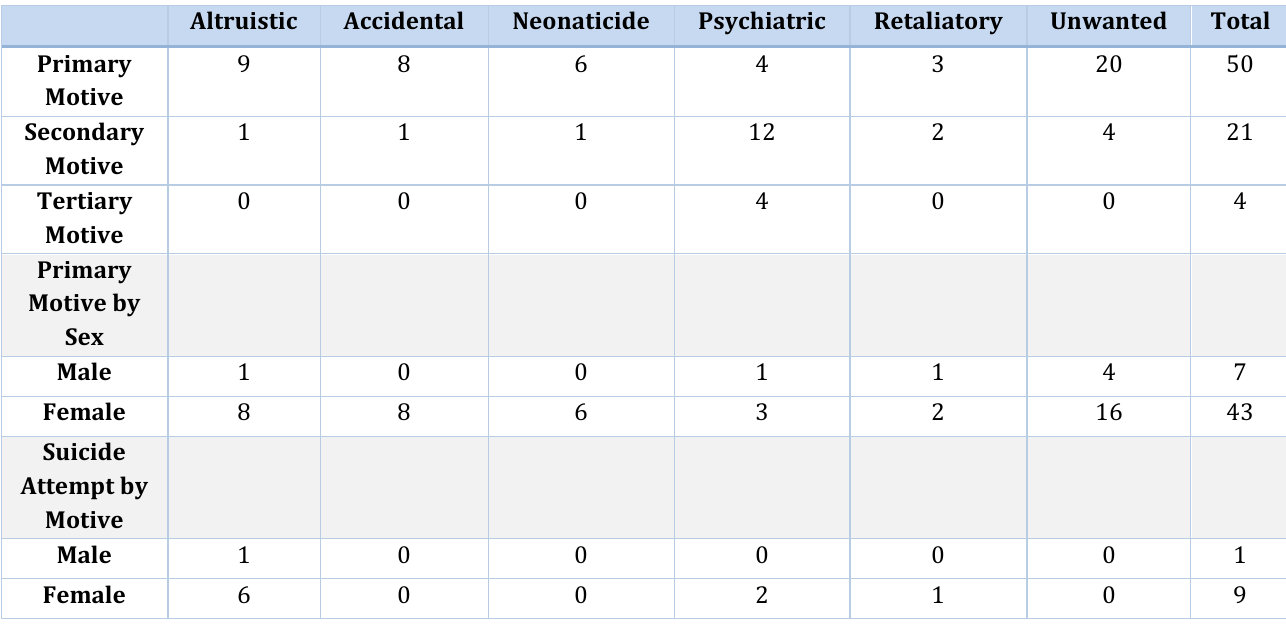
Table 5: Motives for Filicides, Victoria, 1860 –